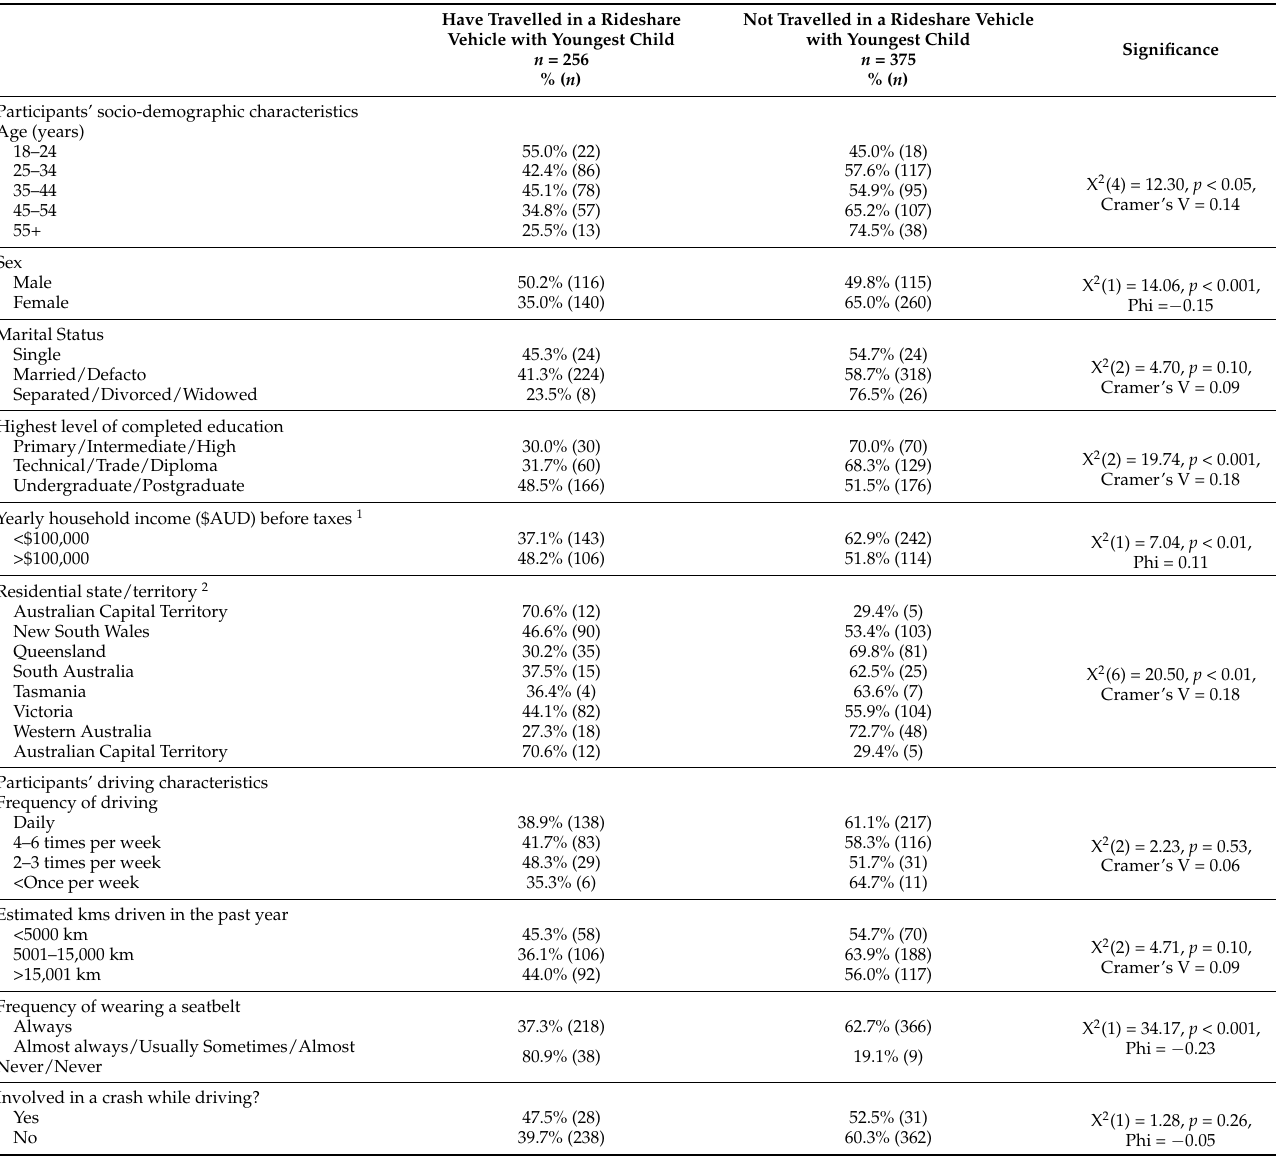
Table 10. Characteristics of parents who have and have not travelled in a rideshare vehicle with their youngest child ( n = 631).